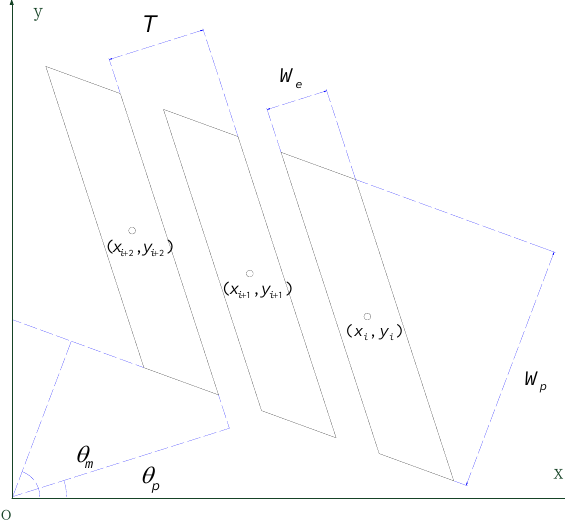
Figure 9. Geometrical model of zebra crossings.